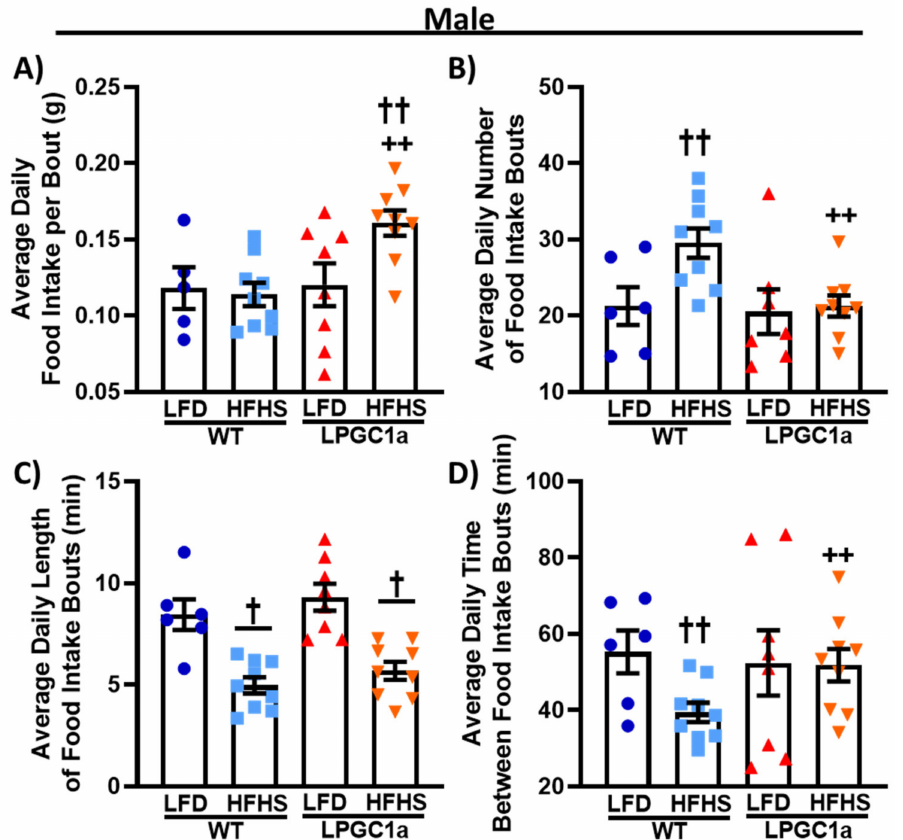
Figure 4. Male LPGC1a mice altered feeding patterns during short-term HFHS feeding. Feeding patterns during the 3 day indirect calorimetry experiments were evaluated in male WT and LPCG1a mice on an LFD and a HFHS diet for ( A ) food intake per feeding bout (g), ( B ) number of daily feeding bouts, ( C ) length of feeding bouts (min), and ( D ) time interval between successive feeding bouts (min). Individual data points and the group means ± SEM are displayed ( n = 7–10). † p < 0.05 main effect of diet, †† p < 0.05 LFD vs. HFHS within genotype, ++ p < 0.05 WT vs. LPGC1a within